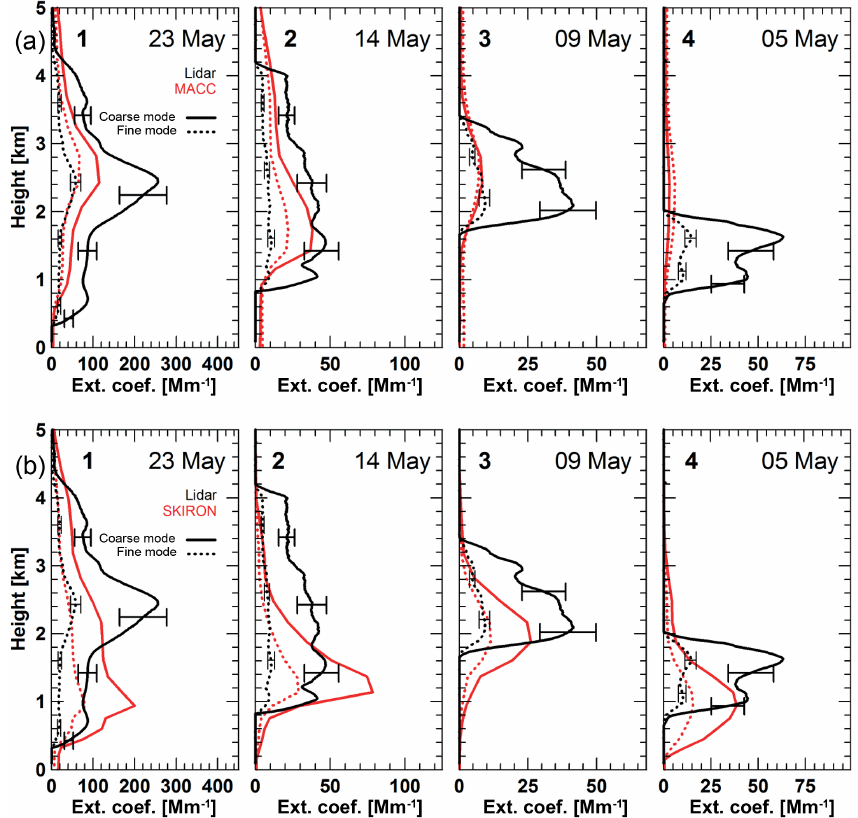
Figure 8. The same as Fig. 7a, except for comparison with MACC/CAMS simulations (a) and SKIRON (b) for all four